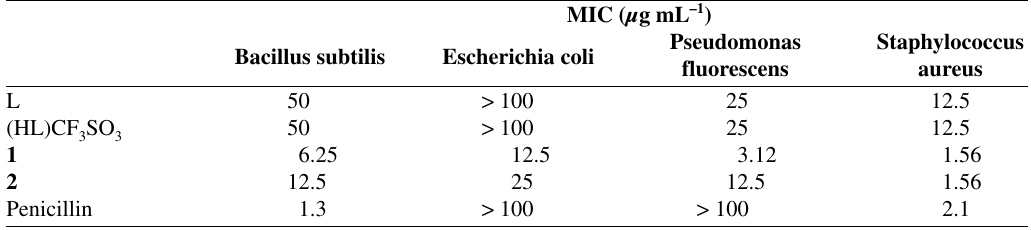
Table 4. Antibacterial